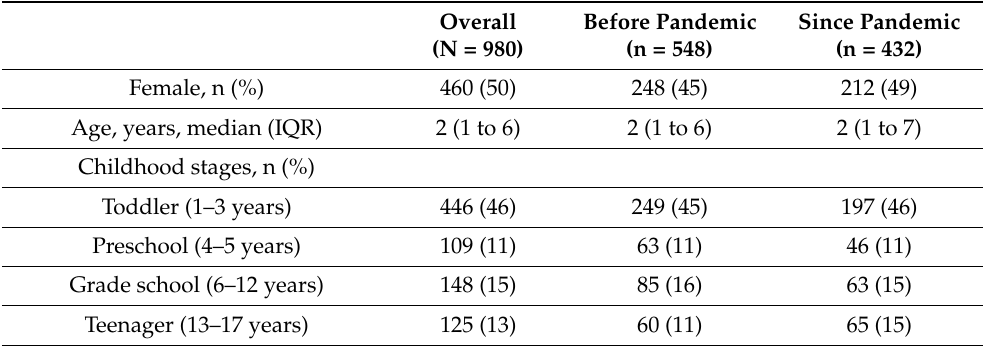
Table 2. Characteristics of the study population, percentages rounded to integers.